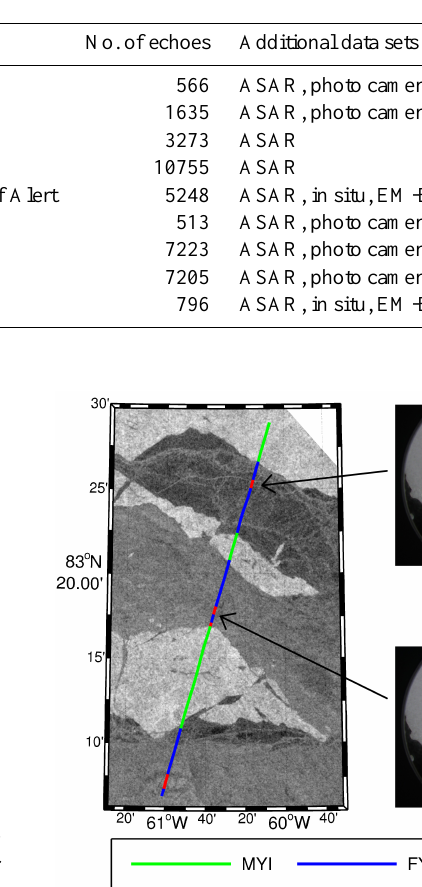
Table 1. Overview of the study areas and numbers of available echo waveforms for each case. We evaluated nine cases: two for leads (L), four for first-year ice (FYI) and three for multi-year ice (MYI), each containing several hundred waveforms. Additional data sets, which have been used for obtaining information about the surface type, are listed in the right column. ASAR indicates that an Envisat ASAR wide-swath image was available.